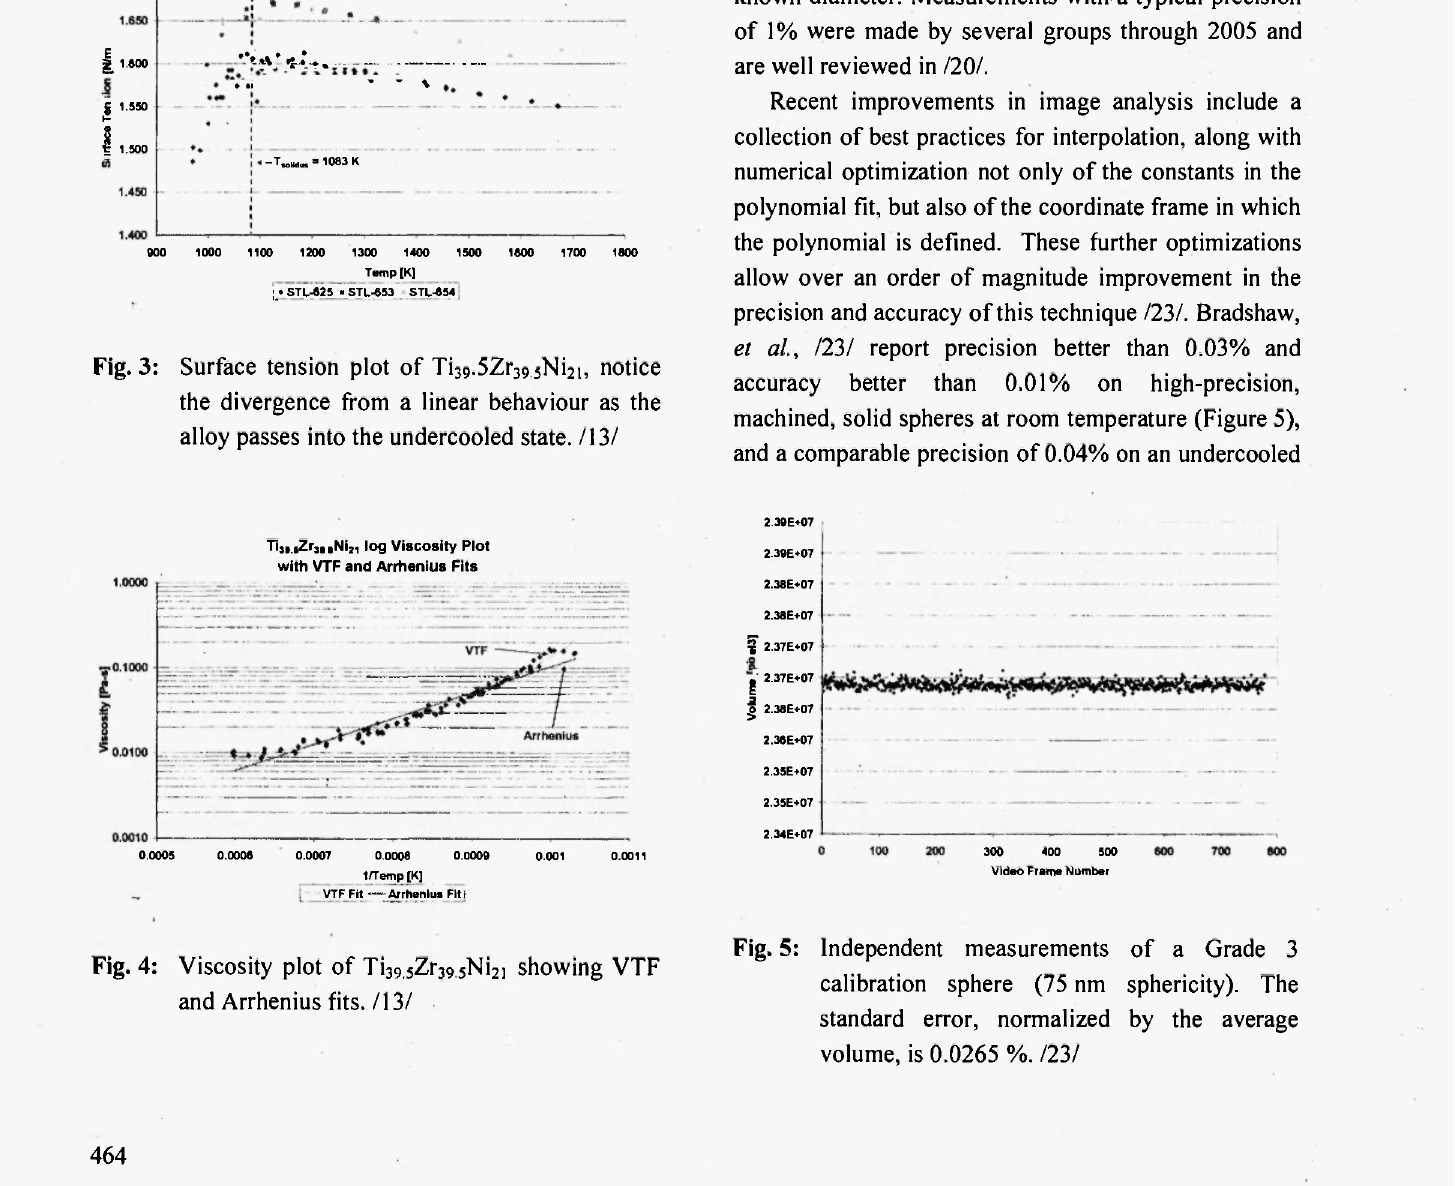
Fig. 3: Surface tension plot of Ti 3 9.5Zr39 5 Ni2i, notice the divergence from a linear behaviour as the alloy passes into the undercooled state. /13/